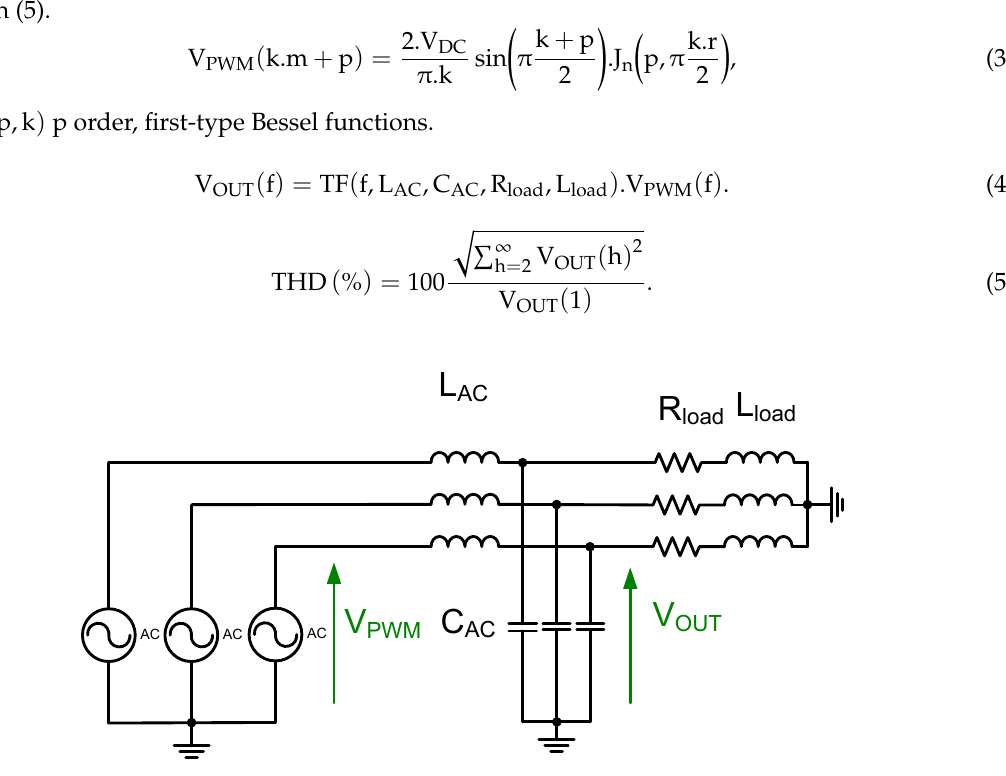
Figure 7. AC filter with equivalent voltage sources.